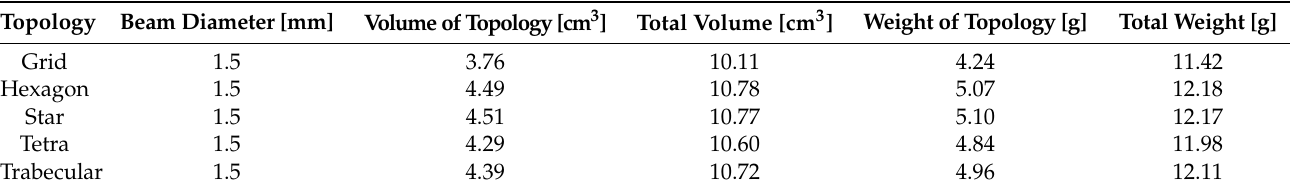
Table 2. Comparison of structures with print parameters and nominal